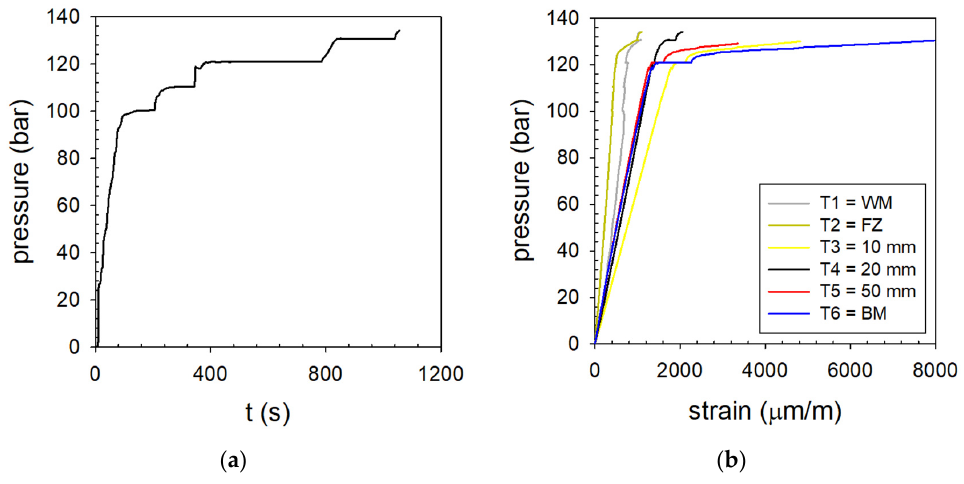
Figure 13. ( a ) Pressure–time and ( b ) pressure–strain curve at burst